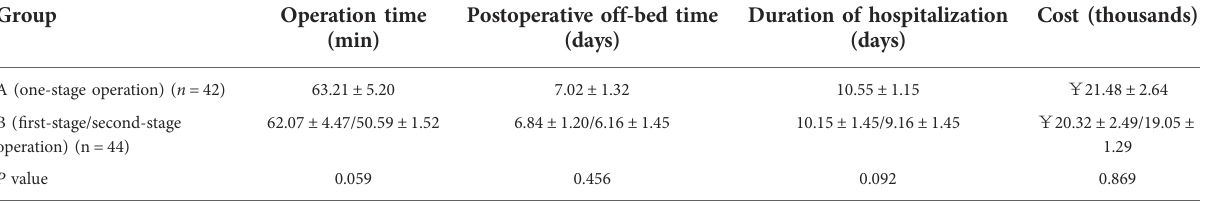
TABLE 2 Operation time, postoperative off-bed time, and days of hospitalization in the two